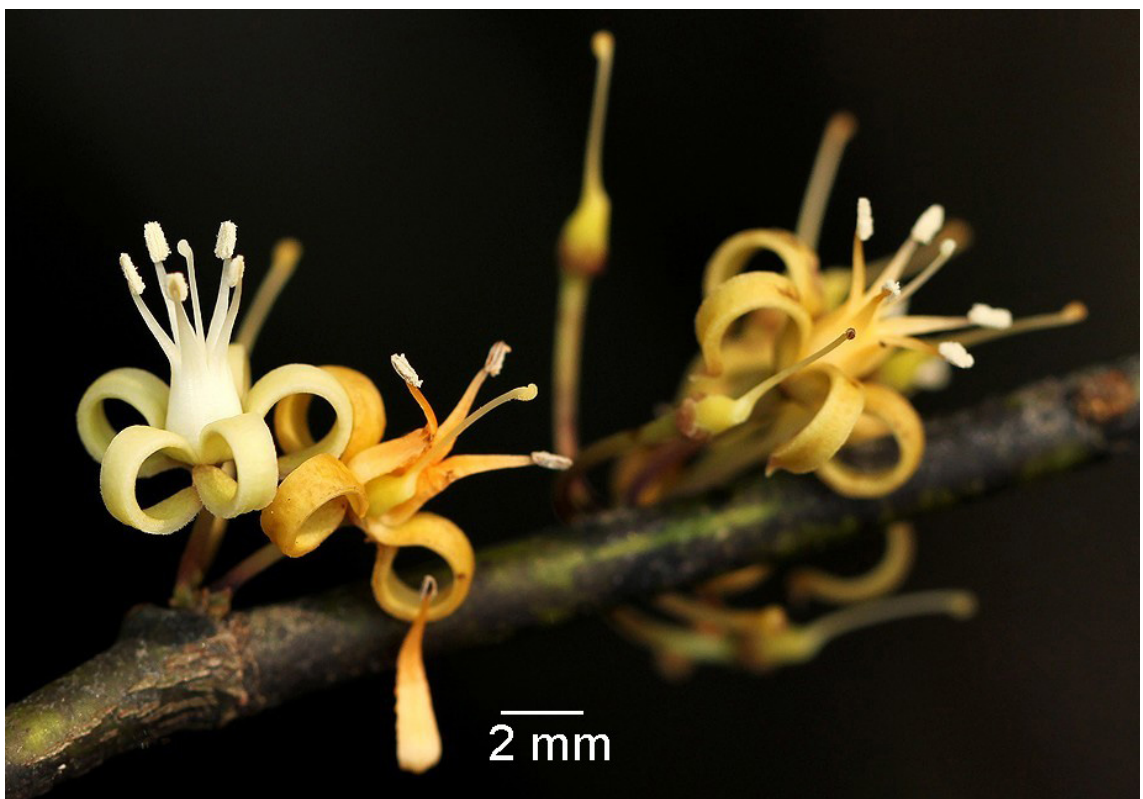
Fig. 3. Rhaphiostylis beninensis (Hook.f. ex Planch.) Planch. ex Benth., like Fig. 2, but also showing ovary and style in older flowers. Photograph by Bart Wursten from Boyekoli Ebale Botany 785 (BR) from Congo Kinshasa (copyright Botanic Garden